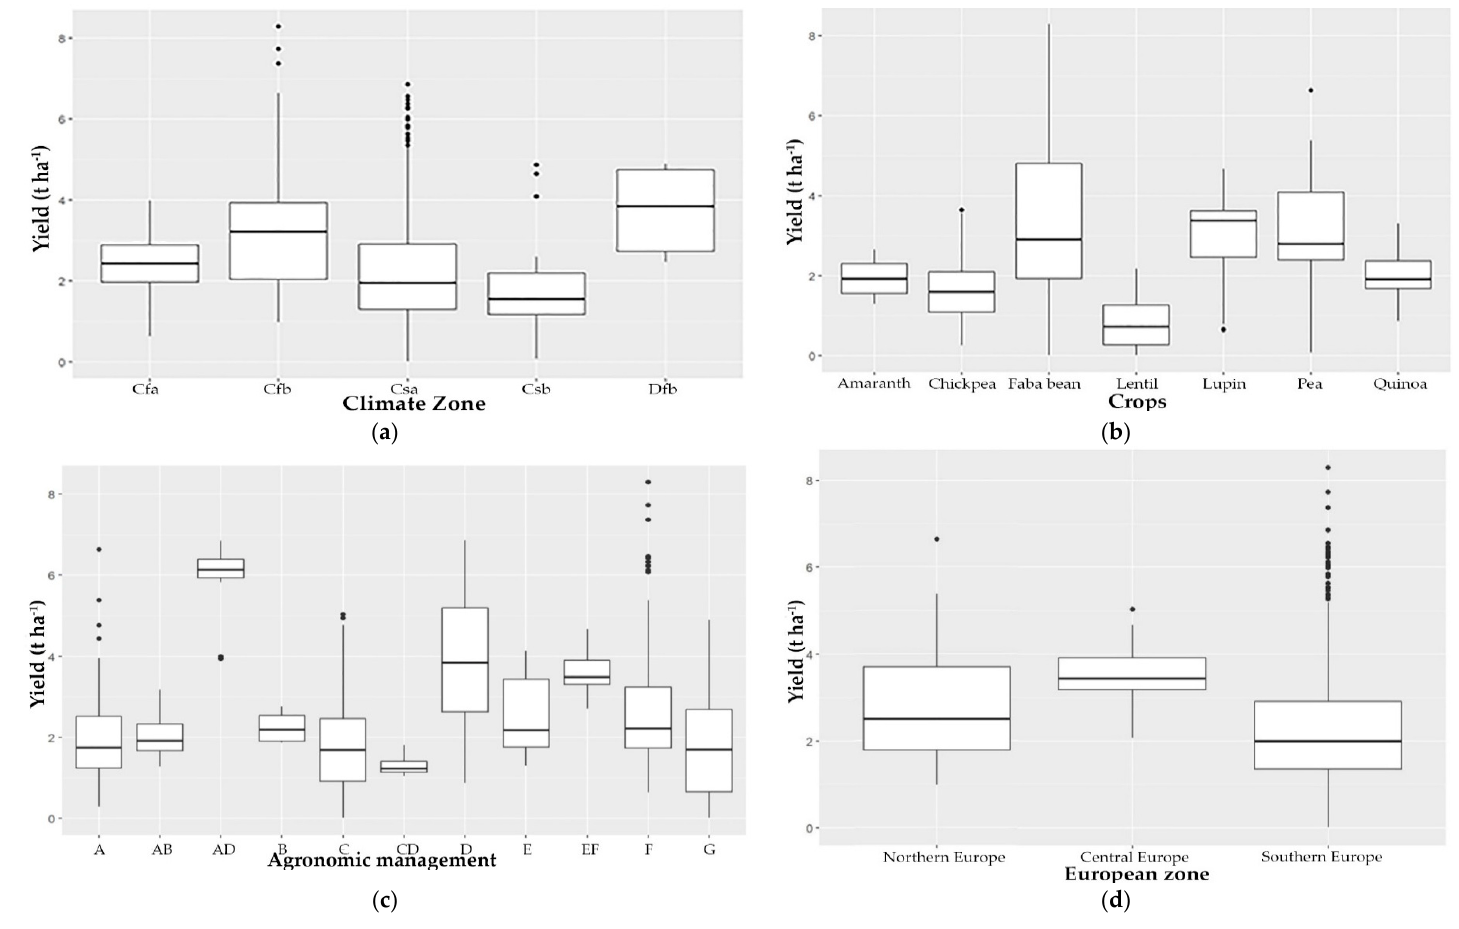
Figure 6. Box-plots of patterns of yield (t ha − 1 ) for all observations (n = 818) across: ( a ) different groups of climatic zones, Cfa: humid subtropical; Cfb: Marin–mild winter; Csa: interior Mediterranean; Csb: coastal Mediterranean:; Dfb: humid continental mild summer, wet all year ( b ) different group of Crops, ( c ) different groups of agronomic management A: deficit irrigation; AB: deficit irrigation and salinity; AD: deficit irrigation and fertilizer; B: salinity; C: tillage; CD: tillage and fertilizer; D: fertilizer; E: sowing density; EF: sowing density and sowing date; F: sowing date; G: weed control; and ( d ) different groups of European zone. Box edges represent the upper and lower quantile with median value shown in the middle of the box. The small circles on the boxplot relate to outliers.